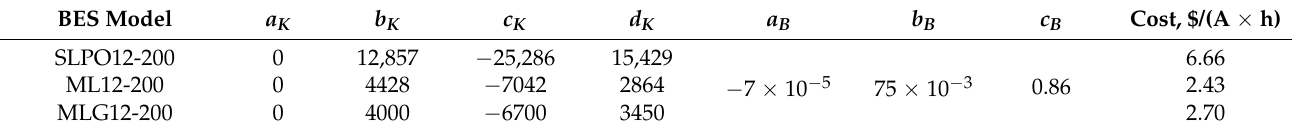
Table 3. BES coefficients of polynomial dependencies and specific unit costs.